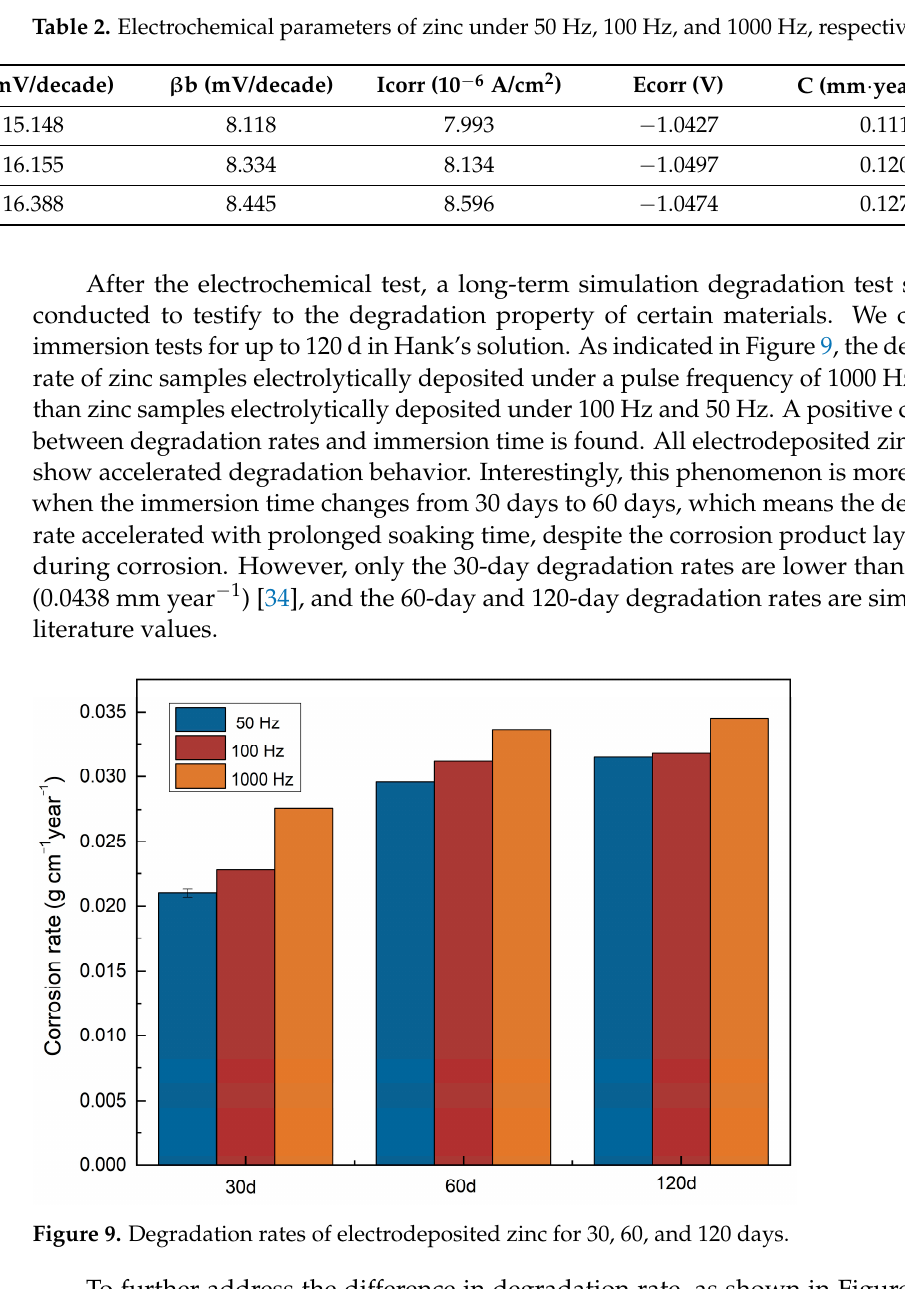
Figure 10. Nyquist plot of zinc under 50 Hz, 100 Hz, and 1000 Hz.